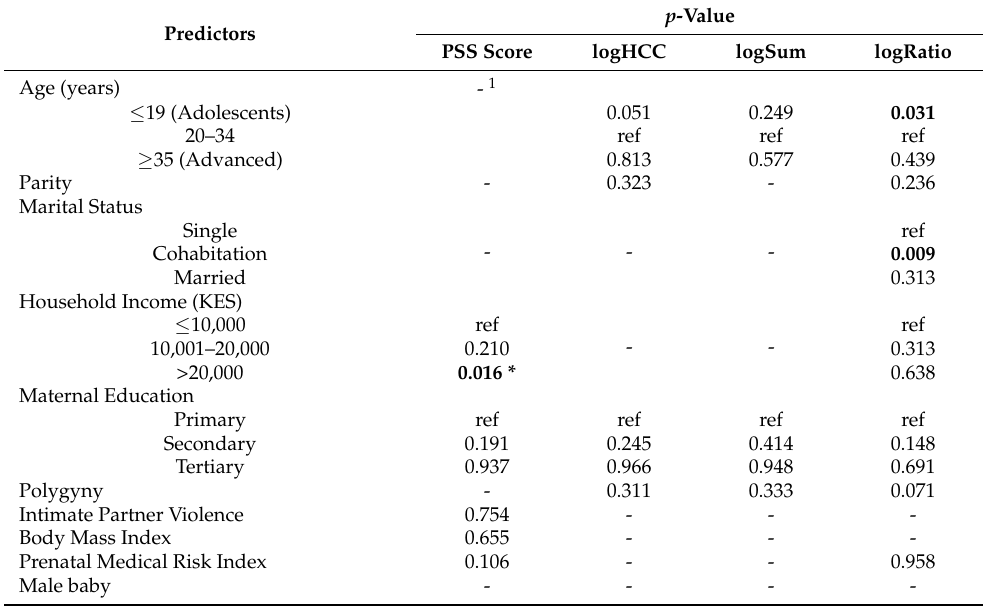
Table 4. Summary of multivariate analysis using simple linear